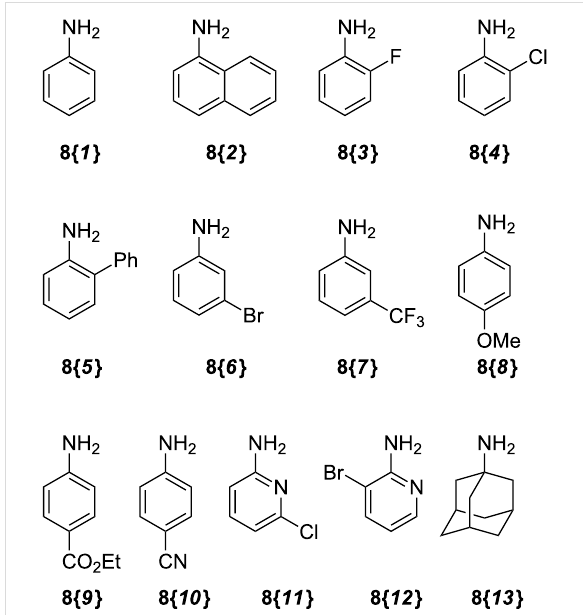
Figure 5: Amine building blocks for library synthesis.